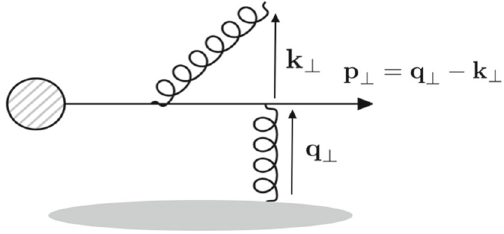
Fig. 1 Two of the contributing Feynman diagrams to the transverse momentum broadening in SIDIS at twist-4 (reproduced from [60]). The left diagram is topologically equivalent to the one used for energy loss in Fig. 2. The right diagram includes cross talk between the parton production and subsequent evolution, which is neglected in energy loss formalisms